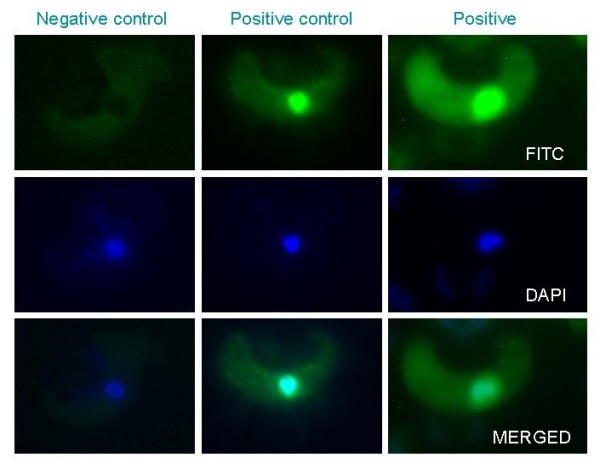
Identification of DNA fragmentation by fluorescent TUNEL assay. Images of P. berghei ookinetes with fragmented DNA marked using a TUNEL assay (In situ cell death detection kit, Fluorescein, Roche) at 21 hours post culture. Positive cells show a bright green nucleus. Negative controls were incubated with only the label solution without the enzyme and positive controls had DNA strand breaks induced with DNase 1 recombinant (3 units/ml for 10 mins at 20°C) before labelling (DNase 1 recombinant, grade 1, Roche). DAPI staining was used to check the location of the nucleus. More detailed methodology is available in Additional file 1.